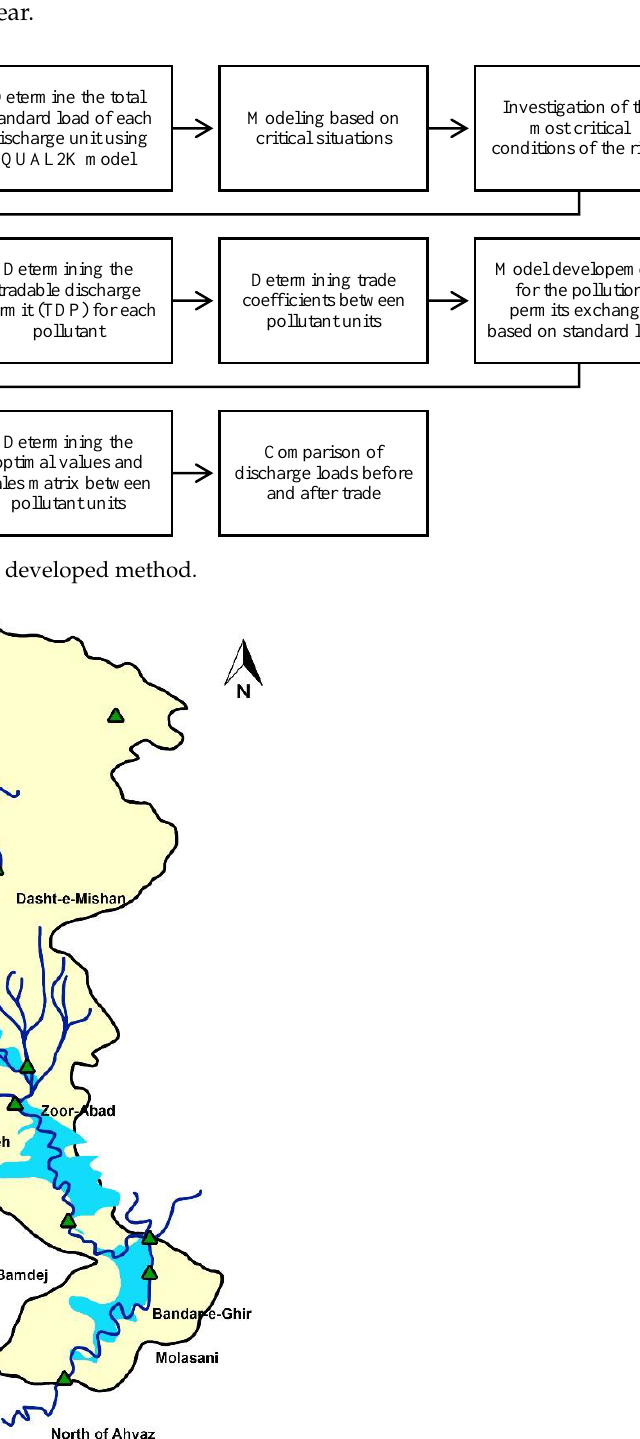
Figure 3. The schematic view of the study area.